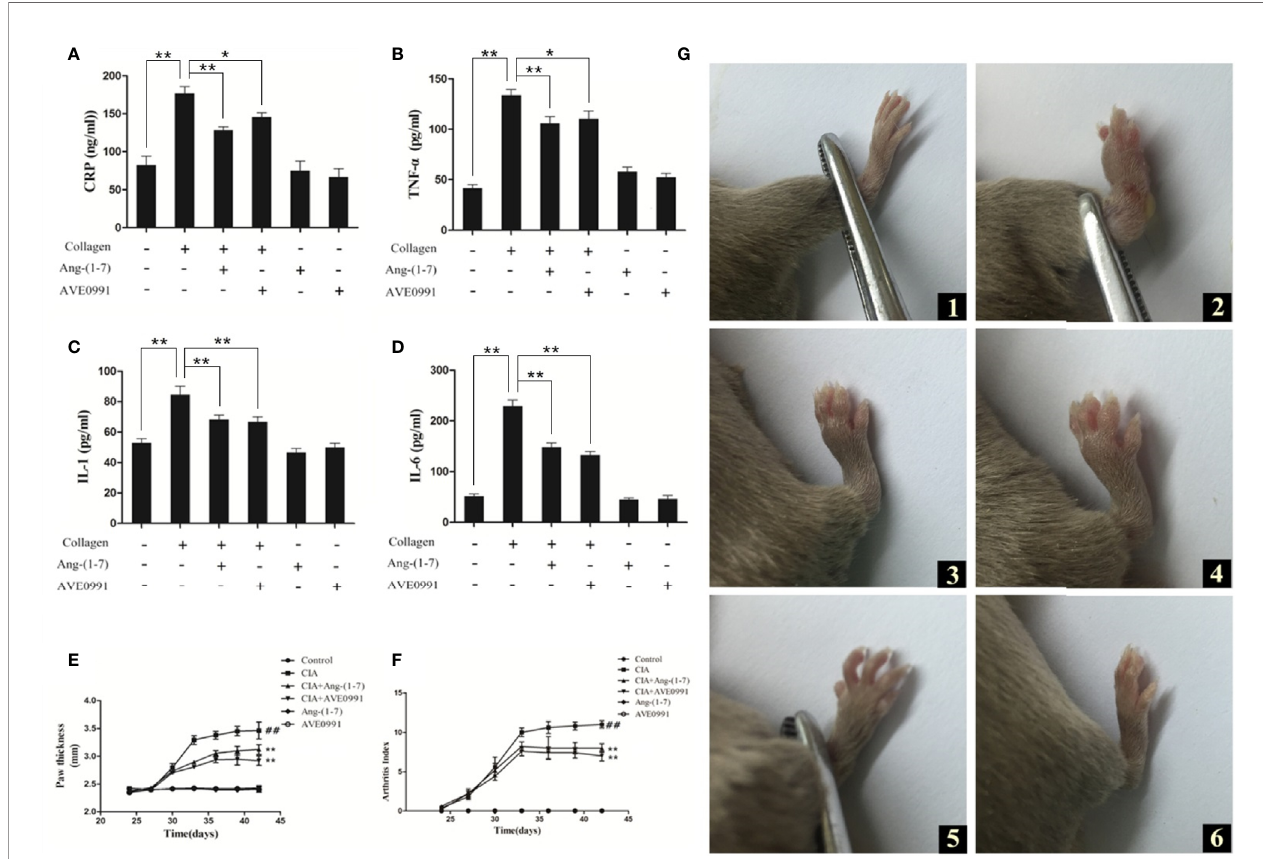
FIGURE 1 | Effect of Ang-(1 – 7) and AVE0991 on development of in fl ammatory factor in mice. The serum cytokine levels of (A) CRP, (B) TNF- a , (C) IL-1 b , and (D) IL-6 were determined using ELISA kits. Values are expressed as means ± SD (n = 6). *P < 0.05, **P<0.01. Effect of Ang-(1 – 7) and AVE0991 on development of hind paw thickness and Arthritis Index in CIA mice. (E) The hind paw thickness of DBA/1 mice was measured every three days in all groups from day 24. Values are expressed as means ± SD (n = 10). (F) The Arthritis Index of DBA/1 mice were measured every three days in all groups from day 24. Values are expressed as means ± SD (n = 10). **: Compared with CIA group, P<0.01; ##: Compared with Control group, P<0.01. Paw swelling in mice. (G) (1) Control group, (2) CIA group, (3) CIA + Ang-(1 – 7) group, (4) CIA + AVE0991 group, (5) Ang-(1 – 7) group, (6) AVE0991